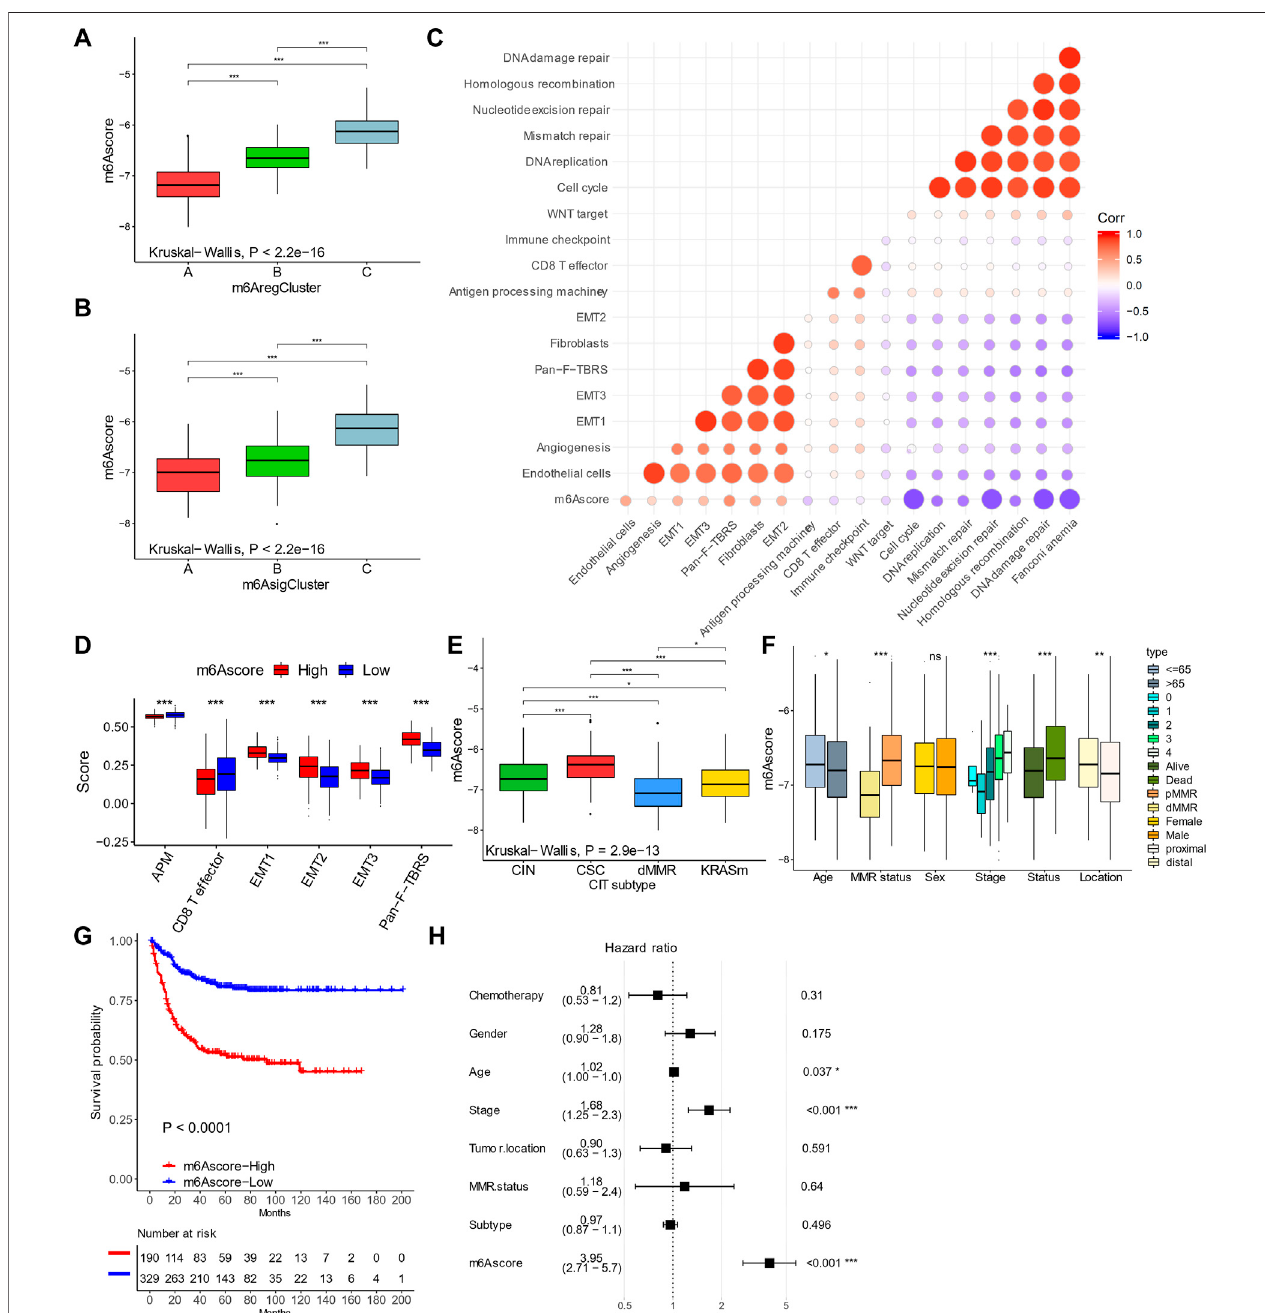
FIGURE 5 | Characteristics of m 6 Ascore in colorectal cancer. (A,B) m 6 Ascores in m 6 A regulator – based (A) and signature – based (B) clusters. (C) Correlations between m 6 Ascores and gene signatures in colorectal cancer. (D) Levels of stromal activity in patients with high and low m 6 Ascores. (E,F) Distribution of m 6 Ascores in patients with different genomic change subtypes and clinical features. (G) Kaplan – Meier curves of patients with high and low m 6 Ascores. (H) Forest plot showing multivariable COX results of m 6 Ascore and clinical features in predicting death. * p < 0.05; ** p < 0.01; *** p < 0.001.